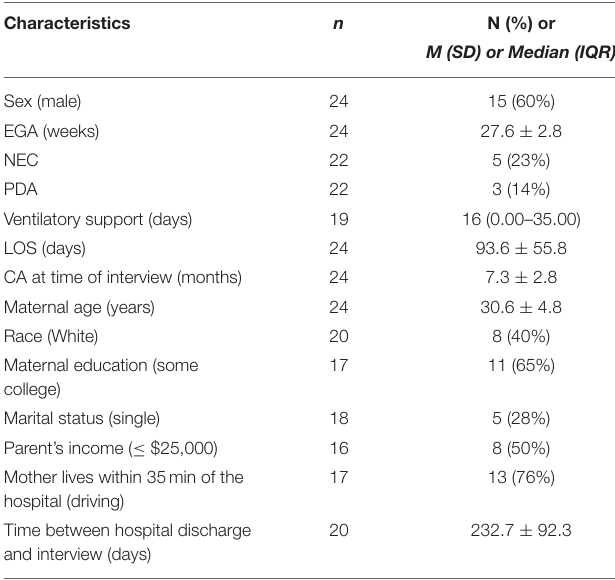
TABLE 1 | Medical and socio-demographic characteristics of participants ( n = 20 mothers of 24